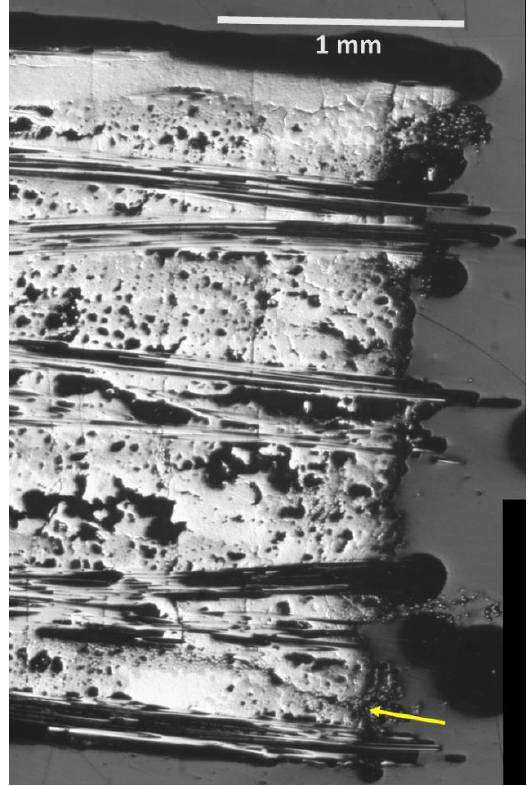
Figure 14. Fracture surface of 111-9.